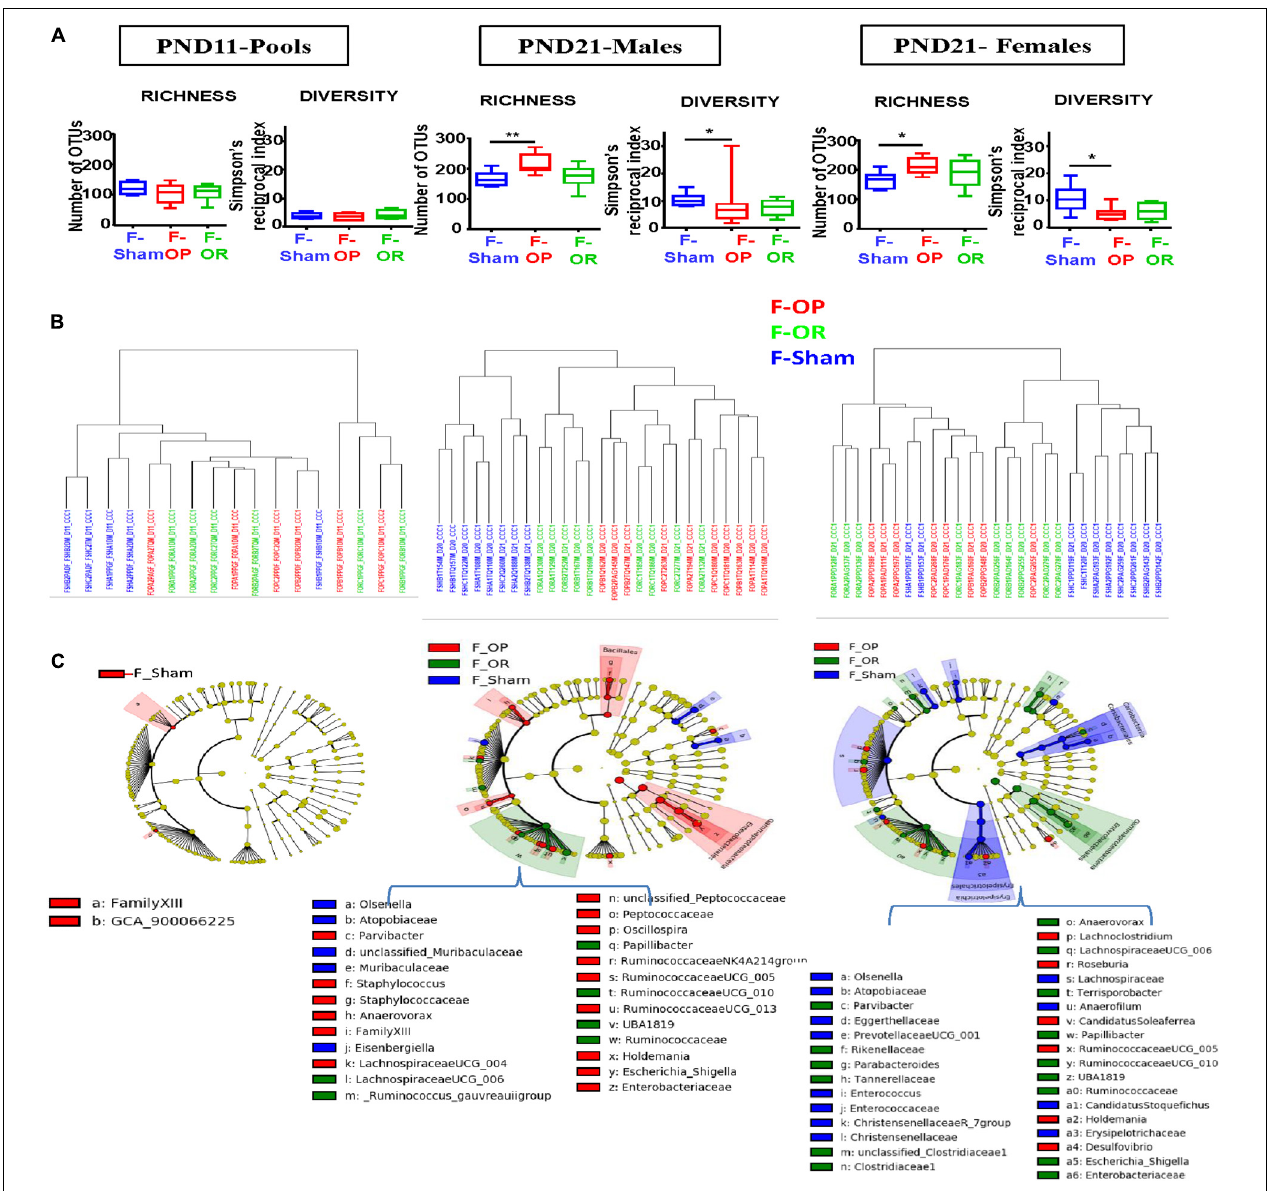
FIGURE 3 | Structure and composition of cecocolonic microbiotas of F344 recipients before weaning ( n = 5 to 10 samples per group and per sex). (A) Observed richness and diversity. (B) Cluster dendrograms of dissimilarity measures (Cao) between individual samples (F-Sham are in blue, F-OP in red, and F-OR in green). (C) Taxonomic cladograms obtained from LEfse analysis of OTU abundances, showing as circles (which diameters are proportional to abundances), taxa that significantly ( p < 0.05) discriminate samples according to the experimental group, on concentric rings from phyla in the innermost one to species in the outermost, see specific color legend for each sampling time (see Supplementary Figure 3 for LDA